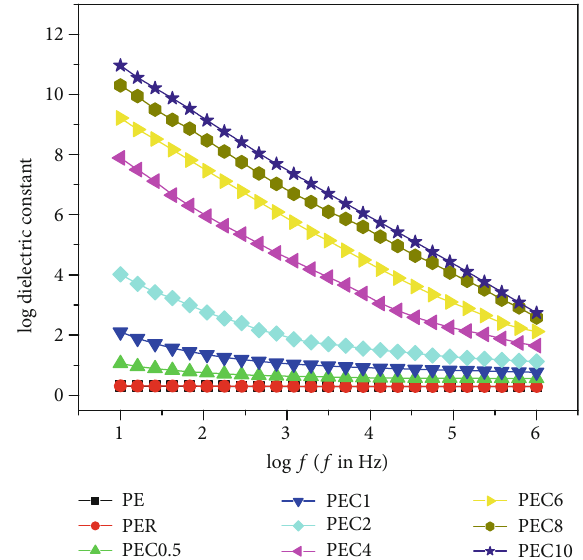
Figure 6: Plots of AC conductivity with respect to frequency for the composite system.